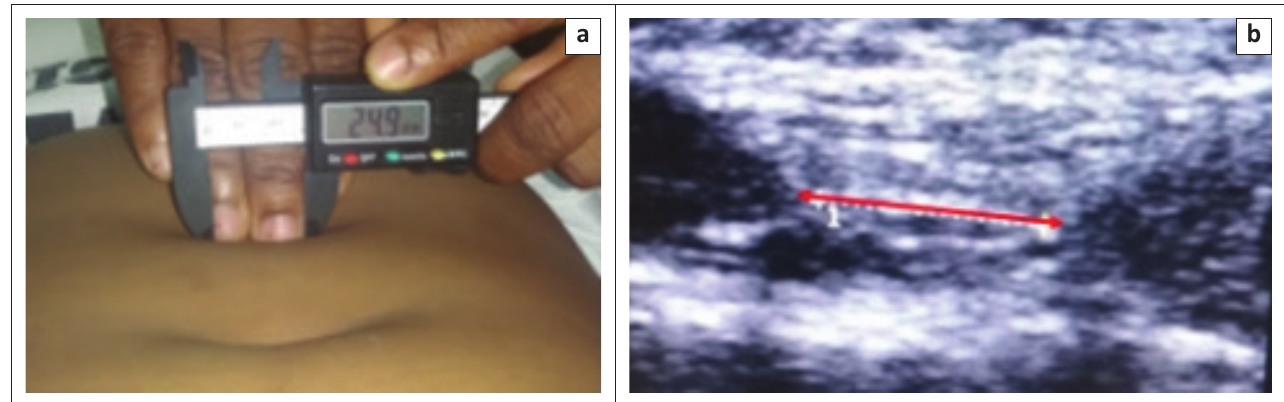
FIGURE 1: Measurement of interrecti distance: (a) caliper measurement and (b) ultrasound measurement.